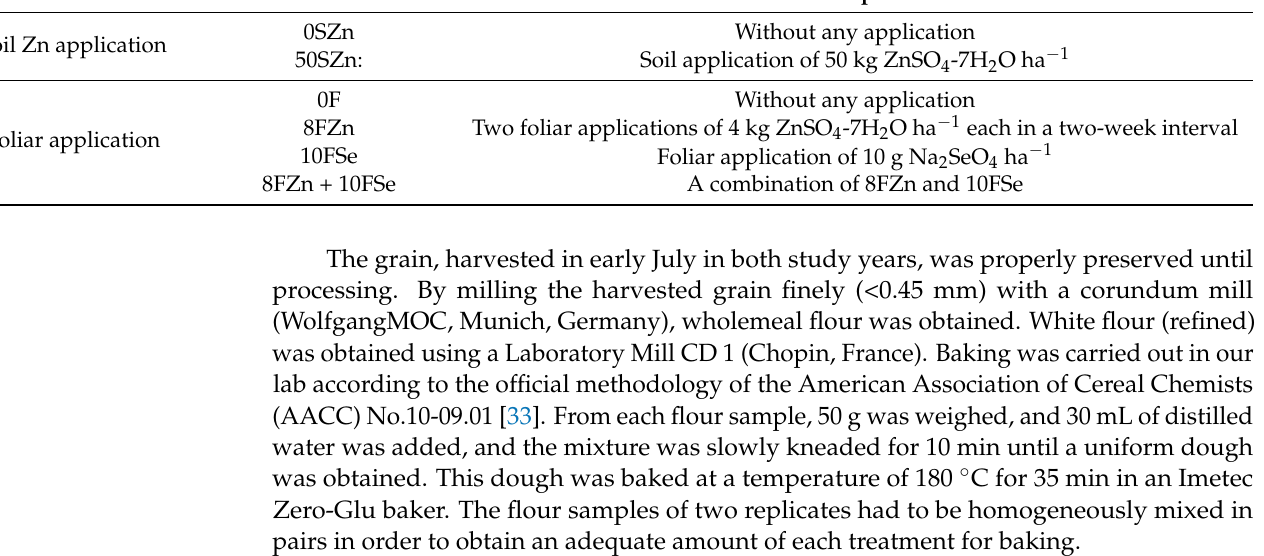
Table 1. Treatments for the main plot (soil Zn application) and subplot (foliar application) factors. Factor